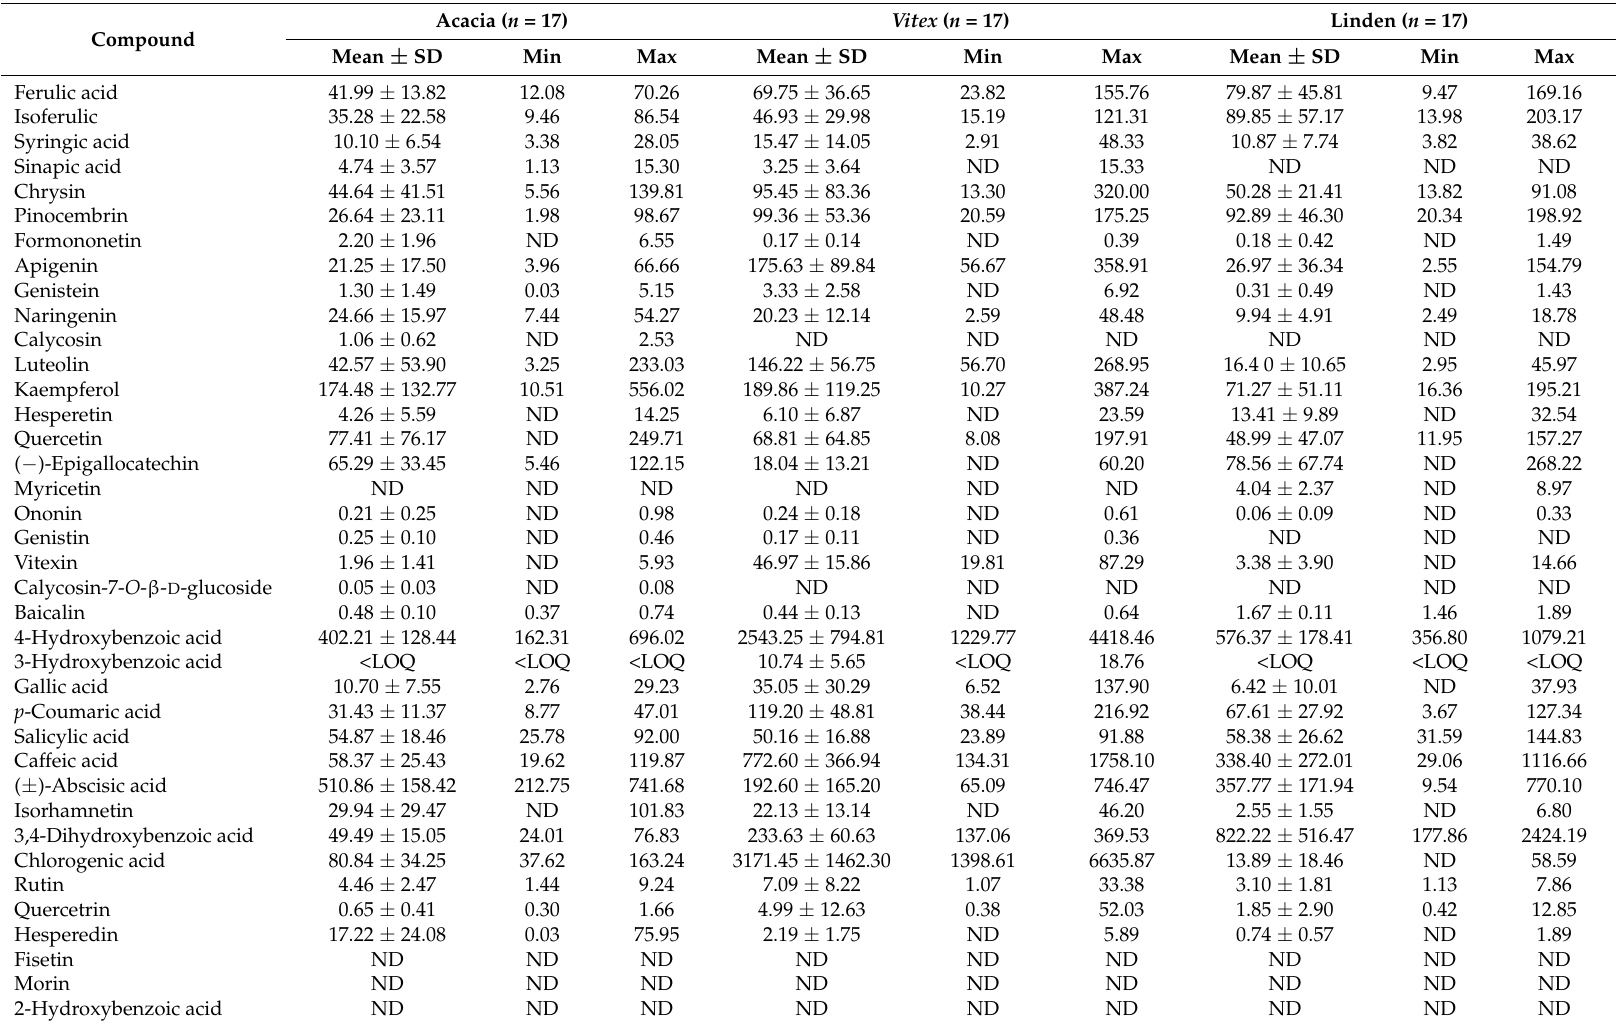
Table 3. Content of phenolic and flavonoid compounds in acacia, Vitex and linden honey samples (ng g − 1